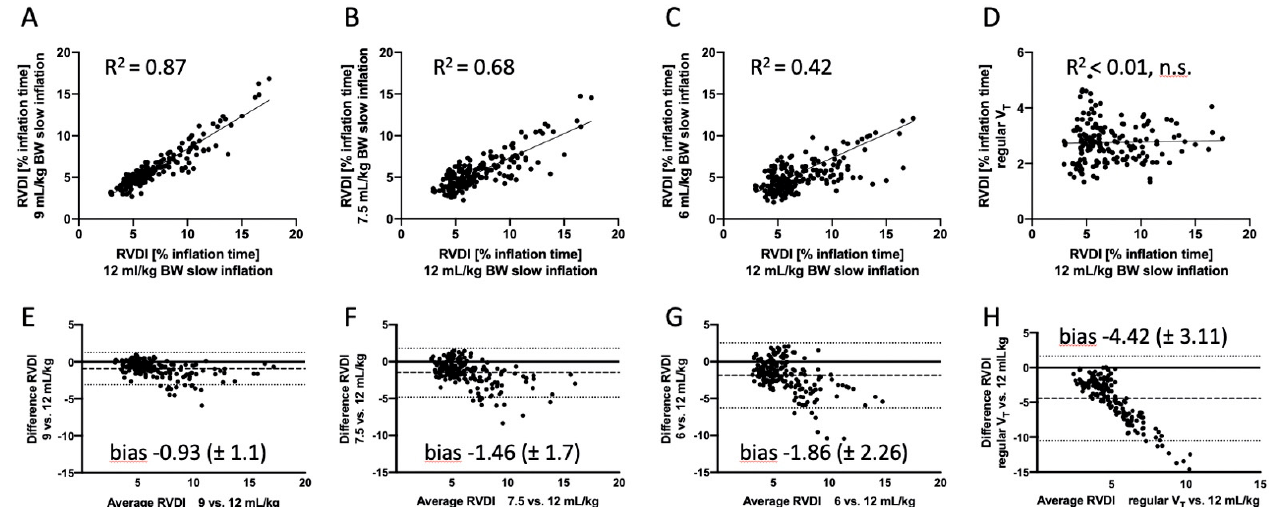
Figure 3. ( A – D ) Comparison (linear correlation) of regional ventilation delay inhomogeneity (RVDI) values (time disparity of regional impedance/time courses as the percentage of inflation time) calculated from different slow inflation volumes and V T depicted on electrical impedance tomography (EIT). The x-axis represents RVDI from slow inflation with 12 mL/kg of body weight (BW); the y-axis represents RVDI from the simulated slow inflations of 9 ( A ), 7.5 ( B ), and 6 ( C ) mL/kg BW, and regular tidal volume (V T ) ( D ). ( E – H ) Comparison of means with differences between RVDI from the original slow inflation of 12 mL/kg BW and RVDI from the simulated slow inflations of 9 ( E ), 7.5 ( F ), and 6 ( G ) mL/kg BW, and regular V T ( H ). Bias ± standard deviations of bias are shown within the graphs. Limits of agreement are indicated by the dotted lines. Table 2. Intraindividual linear correlation analysis of RVDI.